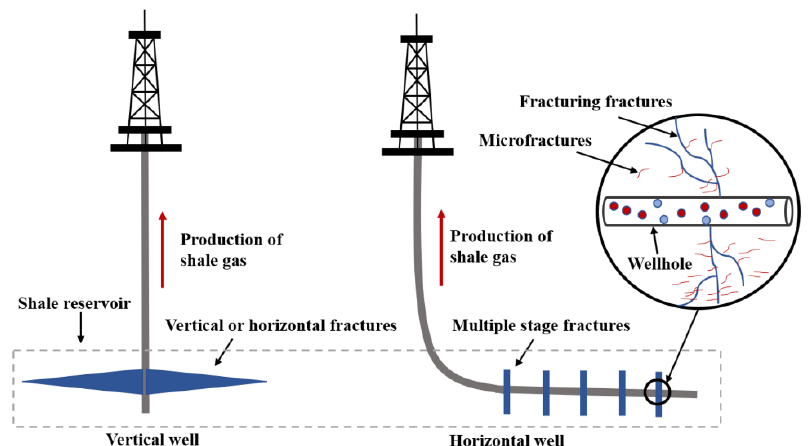
Figure 1. Production comparison between a vertical well and a horizontal well (modified from [15]).